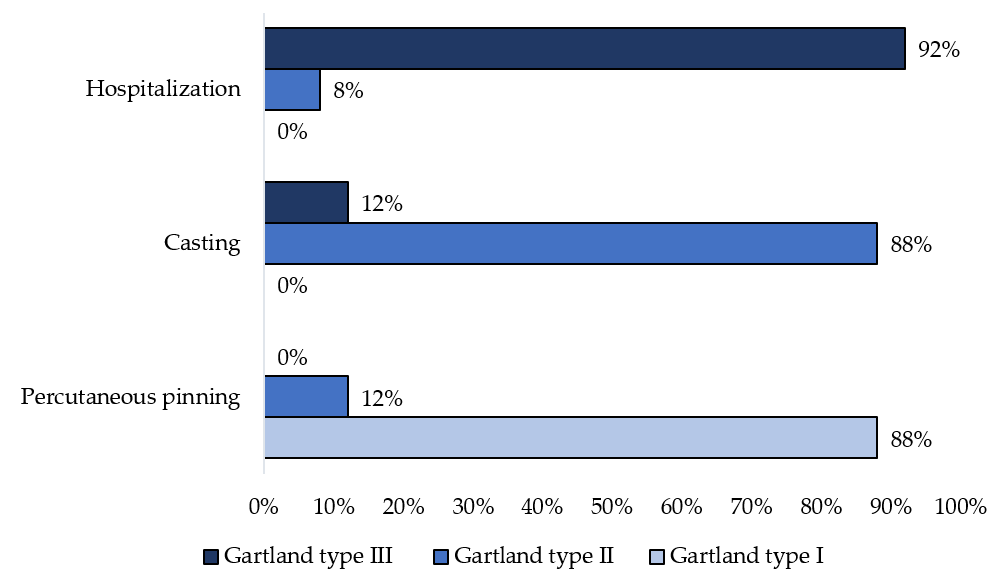
Figure 1 indicates changes of the Gartland classification of supracondylar humerus fractures following casting and percutaneous pinning. Before treatment, there were 46 patients with severely displaced fractures; these were classified as Gartland type III (92%). Following casting, the percentage of those with severely displaced fractures decreased significantly to 12%, while there were no patients with Gartland type III fractures after pinning.